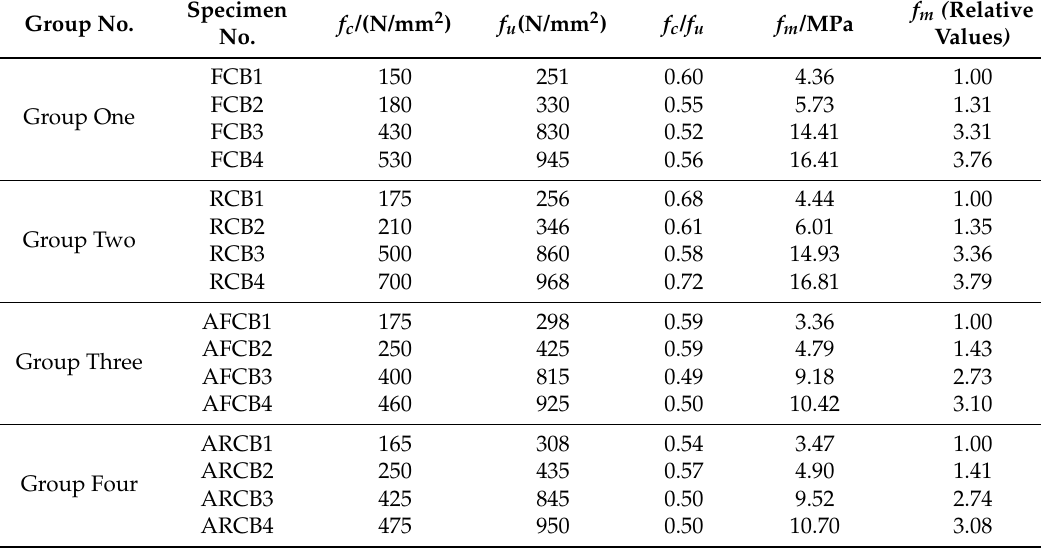
Table 3. Split limit, loading limit and converted compressive strength measured for four groups of